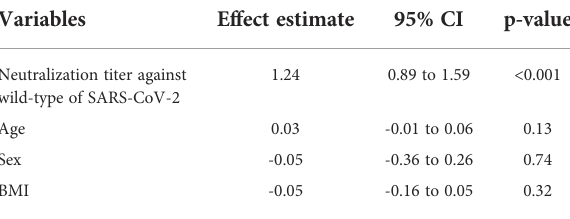
TABLE 2 Effect estimates of multivariate regression analysis for each variable on neutralization